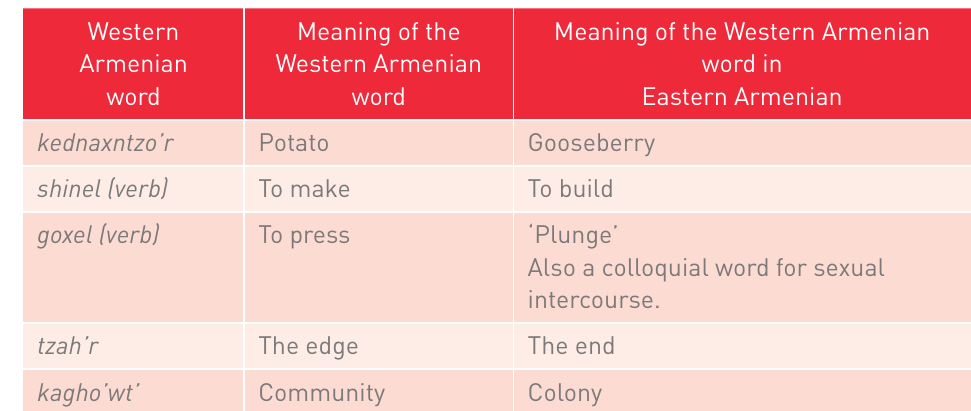
Table 4 Words with Differing